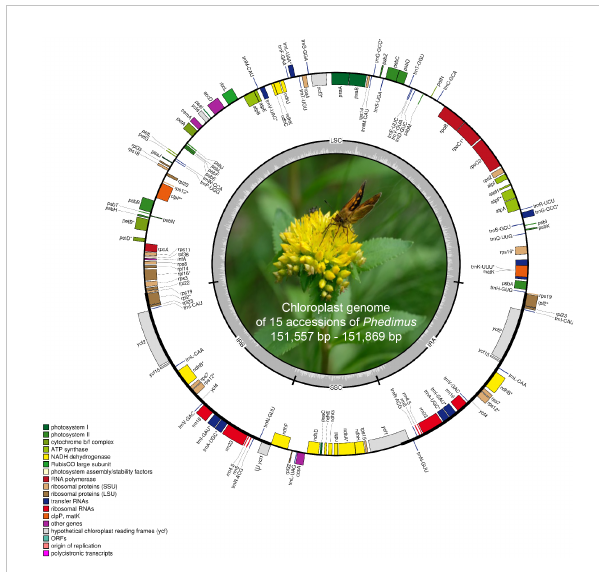
FIGURE 2 Complete plastome map of Phedimus subg. Aizoon species in East Asia. The genes inside and outside of the circle are transcribed in the clockwise and counterclockwise directions, respectively. Genes belonging to different functional groups are shown in different colors. The thick lines indicate the extent of the inverted repeats (IR A and IR B ) that separate the genomes into small single copy (SSC) and large single copy (LSC)